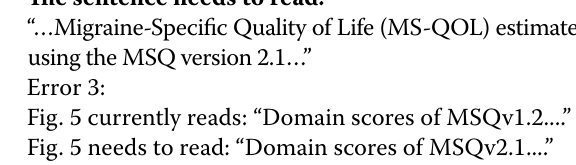
Fig. 5 currently reads: “Domain scores of MSQv1.2....” Fig. 5 needs to read: “Domain scores of